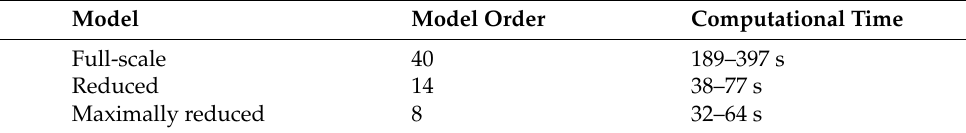
Table 4. Computation time vs. model order. Reproduced from Goyal and Barooah [108].